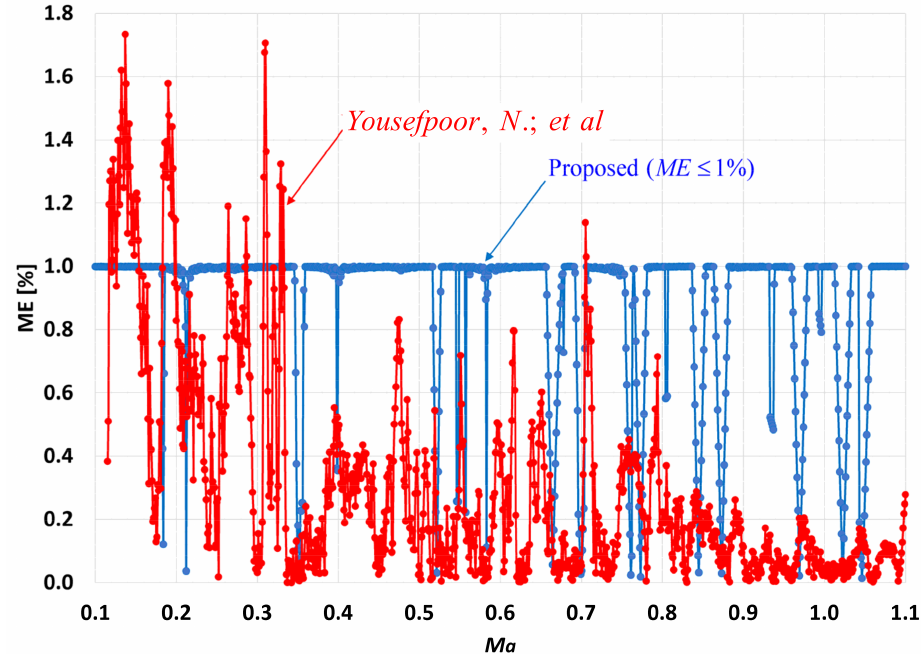
Figure 9. LTHD-optimal actual ME results for N = 7: analytical (proposed) vs. obtained in